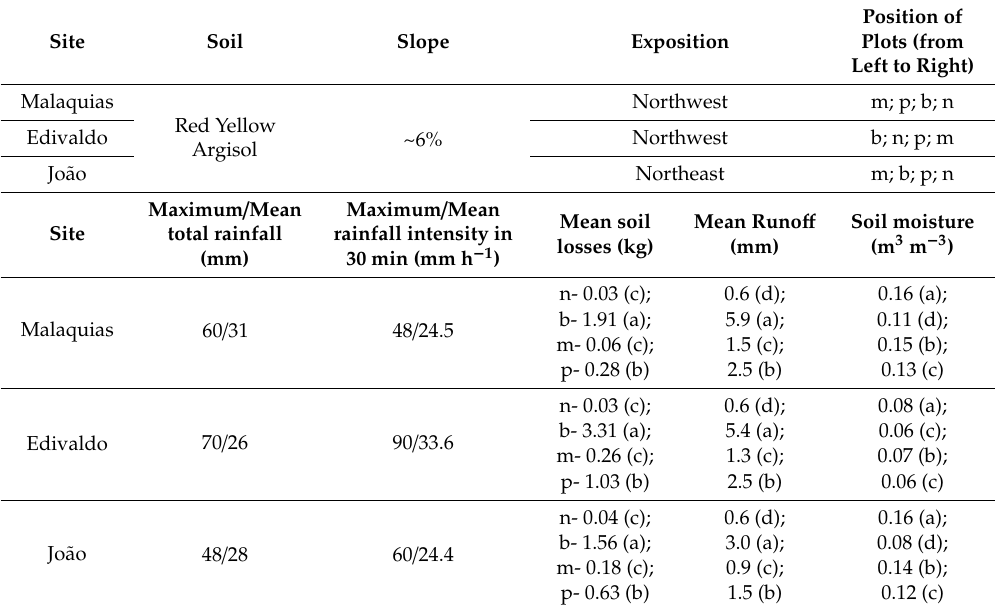
Table 2. General characteristics (mean values and Tukey test for all seven events in each site) for the plots with surface covers: n—Natural; b—Bare soil; m—Mulch; and p—Palma. Site Soil Slope Exposition